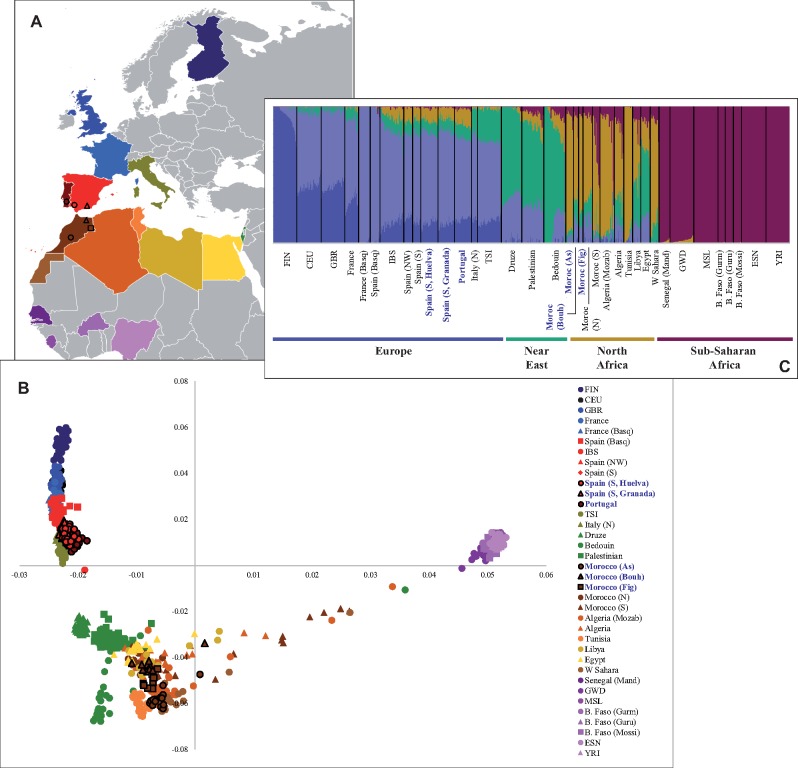
Overview of the genetic structure and global ancestry inference in a selection of European, Near Eastern, and African populations. (A) Countries represented in the database built for comparative analyses. The location of western Mediterranean samples studied here is highlighted in the map with symbols. (B) Principal components analysis (PCA). (C) ADMIXTURE plot for K = 5 ancestral clusters in the populations ordered by geographic affiliation. Both in (B) and (C), the populations genotyped in the present study are marked in bold blue face.